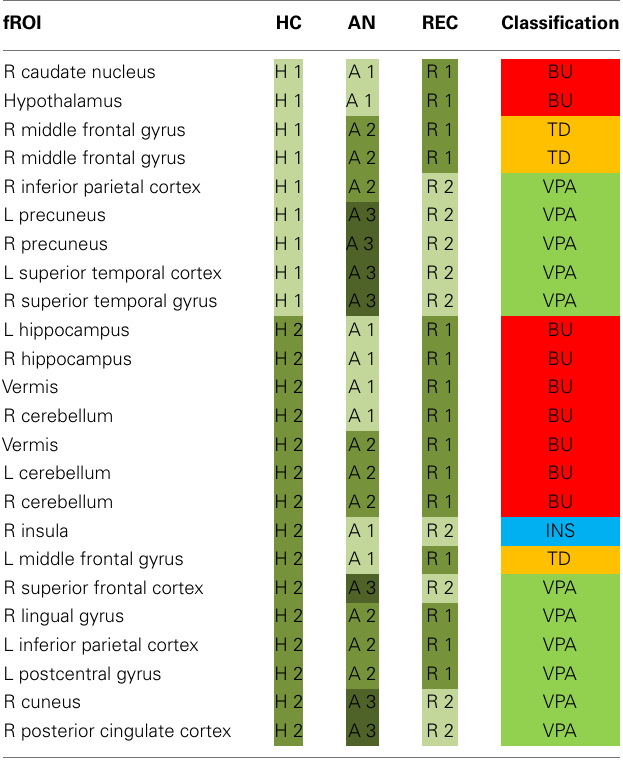
Table 3 | Functional clustering of fROIs for each group